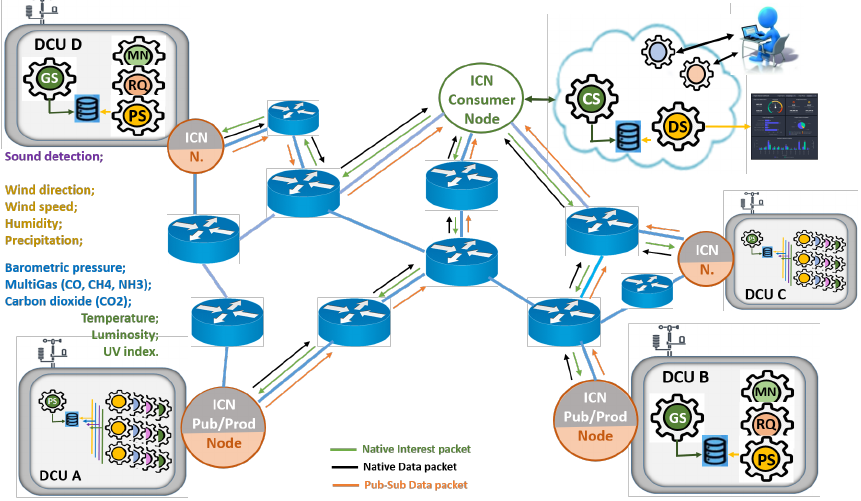
Figure 10. Use case 3: multiples services in the same ICN